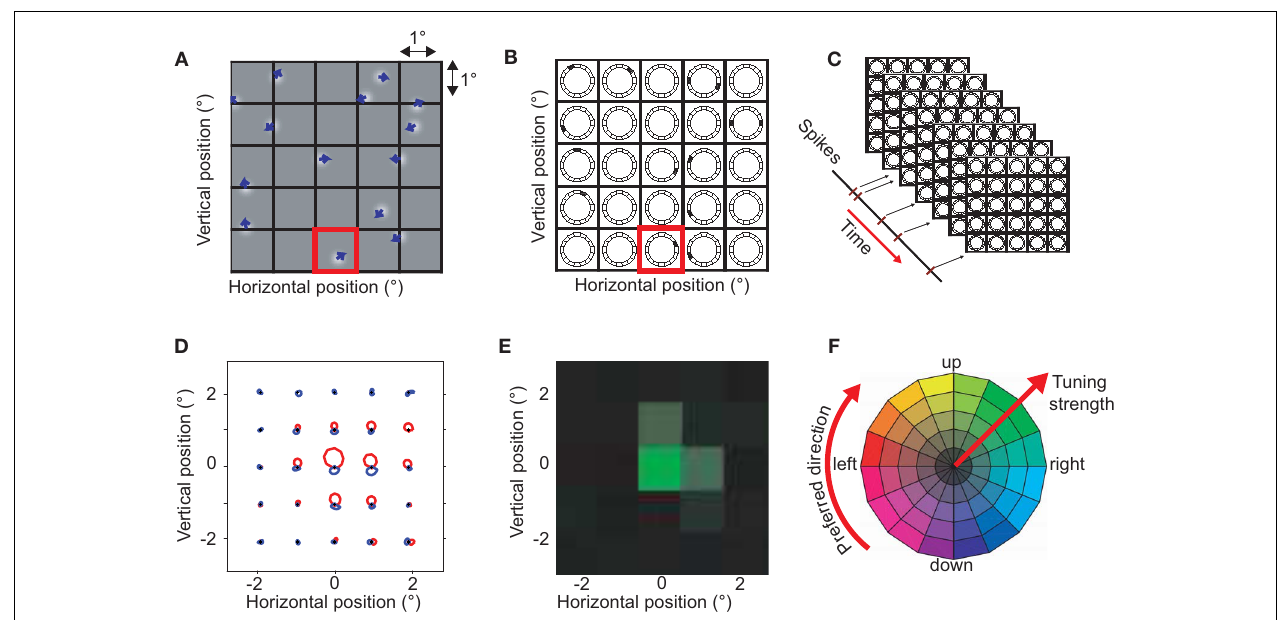
the neural response and the sequence of space-direction histograms. (D) The STA space-direction histograms for 25 spatial grid locations for one example neuron.This representation shows the complete direction tuning curve at each grid location. Red represents excitatory directions, blue suppressive (see Materials and Methods; E) For simplicity of the visual representation, we reduced the STA histograms of (D) to a single preferred direction (represented as a hue), and the strength of the direction preference (represented as color saturation).This example neuron had a strong preference for upward motion in one spatial location (green) and a weak preference for that same direction of motion in two neighboring locations (pale green). (F) The color wheel used to represent preferred direction and strength of the direction tuning. High saturation corresponds to highly direction selective